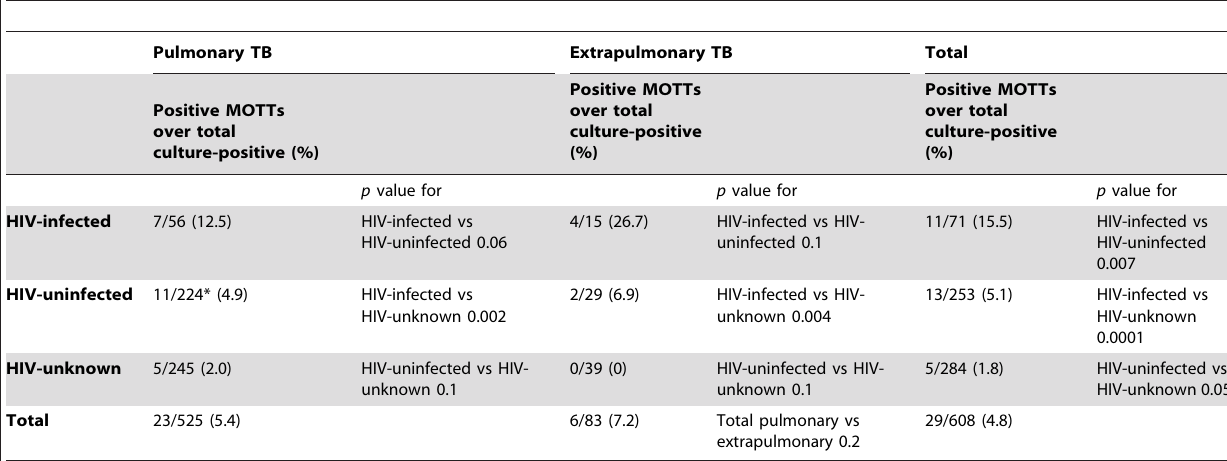
Table 13. Comparative frequency of Mycobacteria other than Tuberculosis Mycobacteria (MOTTs) isolated in culture-positive specimens of pulmonary and extrapulmonary TB patients according to their HIV status.